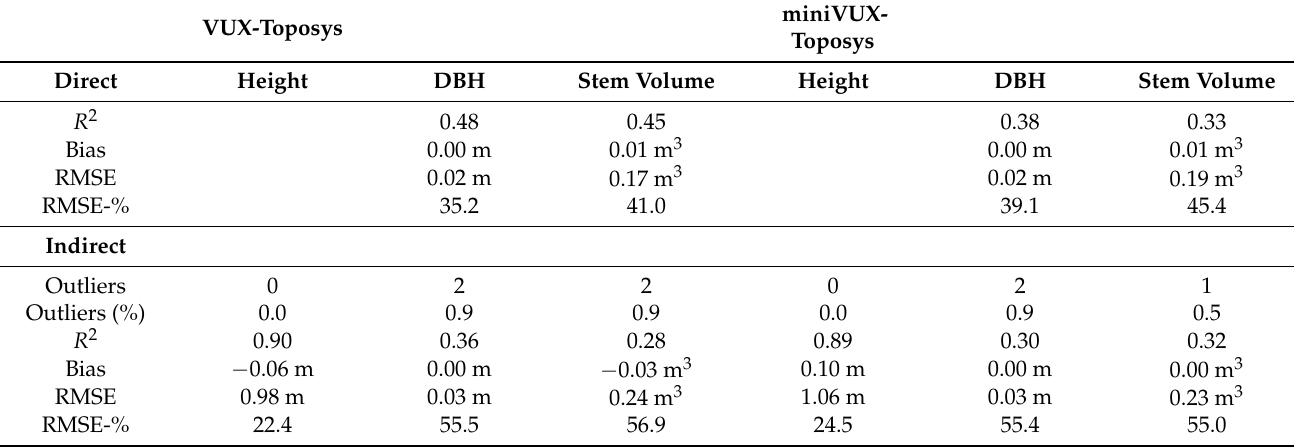
Table 6. Statistical descriptors for Figures 6 and 7. The values were calculated using Equations (10)–(12) after the false links and outlier values were deleted. The values for direct height growth determination are excluded because this would produce the same values as in indirect growth determination. R 2 values refer to the least-squares fits.